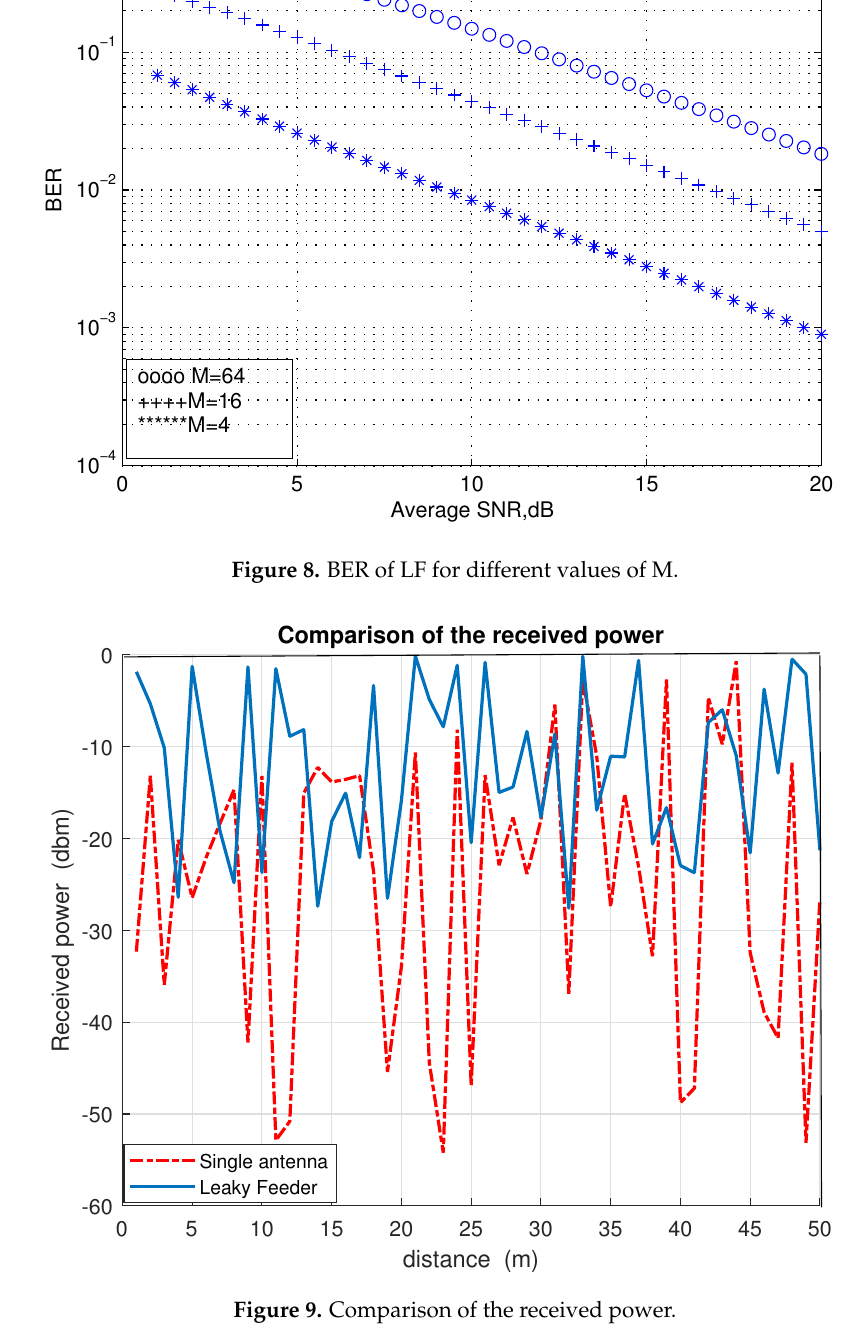
Figure 9. Comparison of the received